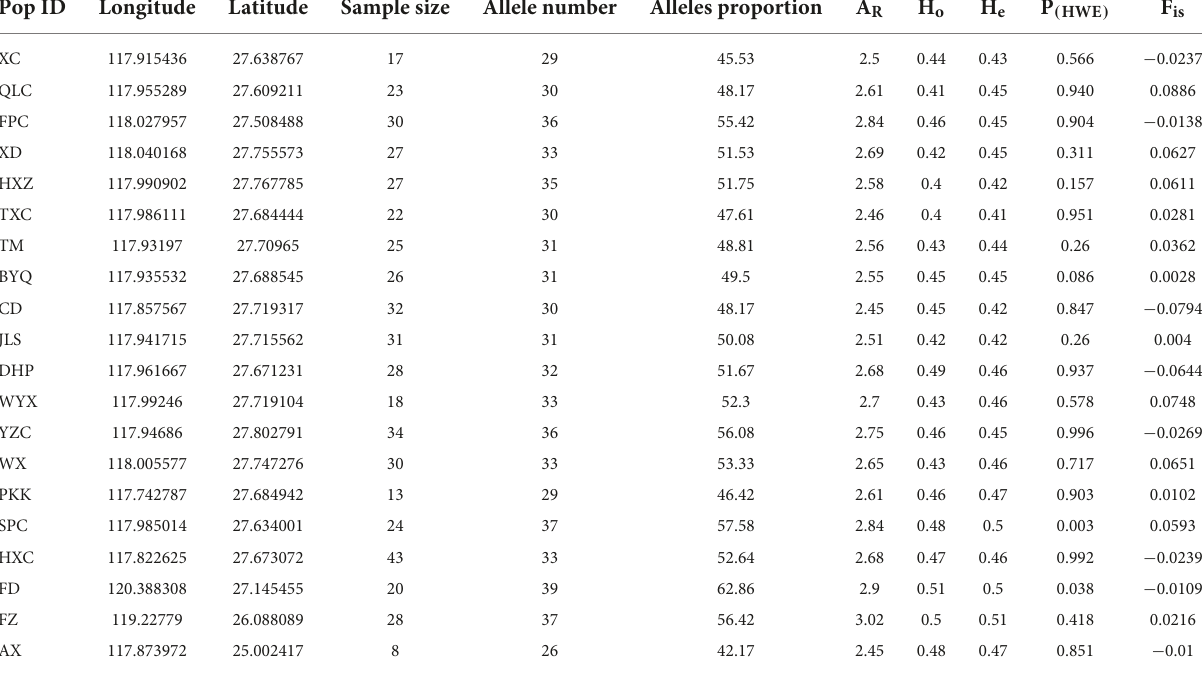
TABLE 1 Genetic diversity and geographic information of 20 S empoasca populations based on 10 microsatellite